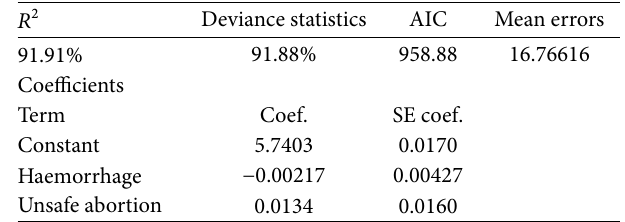
Table 4: Summary of the Poisson model based on the two signif- icant physiological causes (haemorrhage and unsafe abortion), 푅 2 = 91.91 %